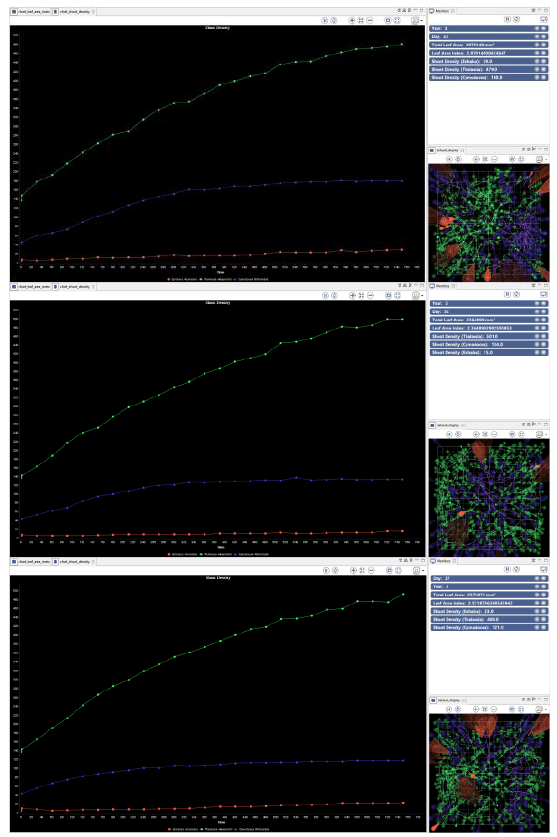
Table 2. Shoot density average of experiment as compared to seagrass data (Vermaat et al., 1995). Shoot densities for each of the modelled species were then plotted into a graph. Using the previously described coefficients on the model, a stable and reproducible plot outcomes can be observed over multiple simulations. Thalassia hemprichii had the highest shoot density, followed by Cymodocea rotundata , with Enhalus acoroides being the least successful. Using random seed values for each run, multiple runs from the same coefficients yielded similar results over 2 years.